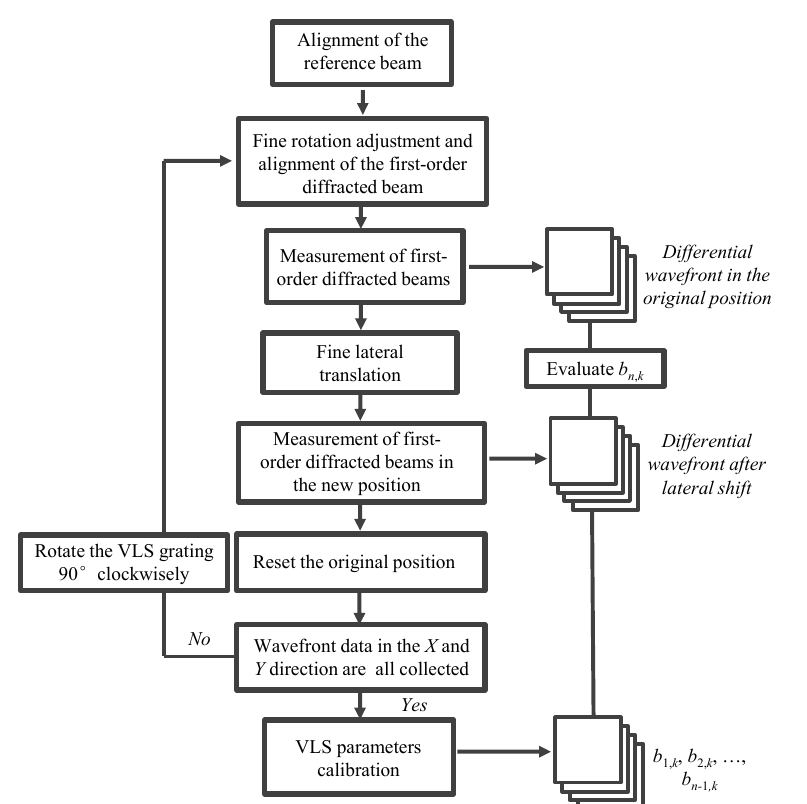
Figure 11. Flow diagram indicating the measurement procedure for the self-calibration of the large- scale VLS grating.